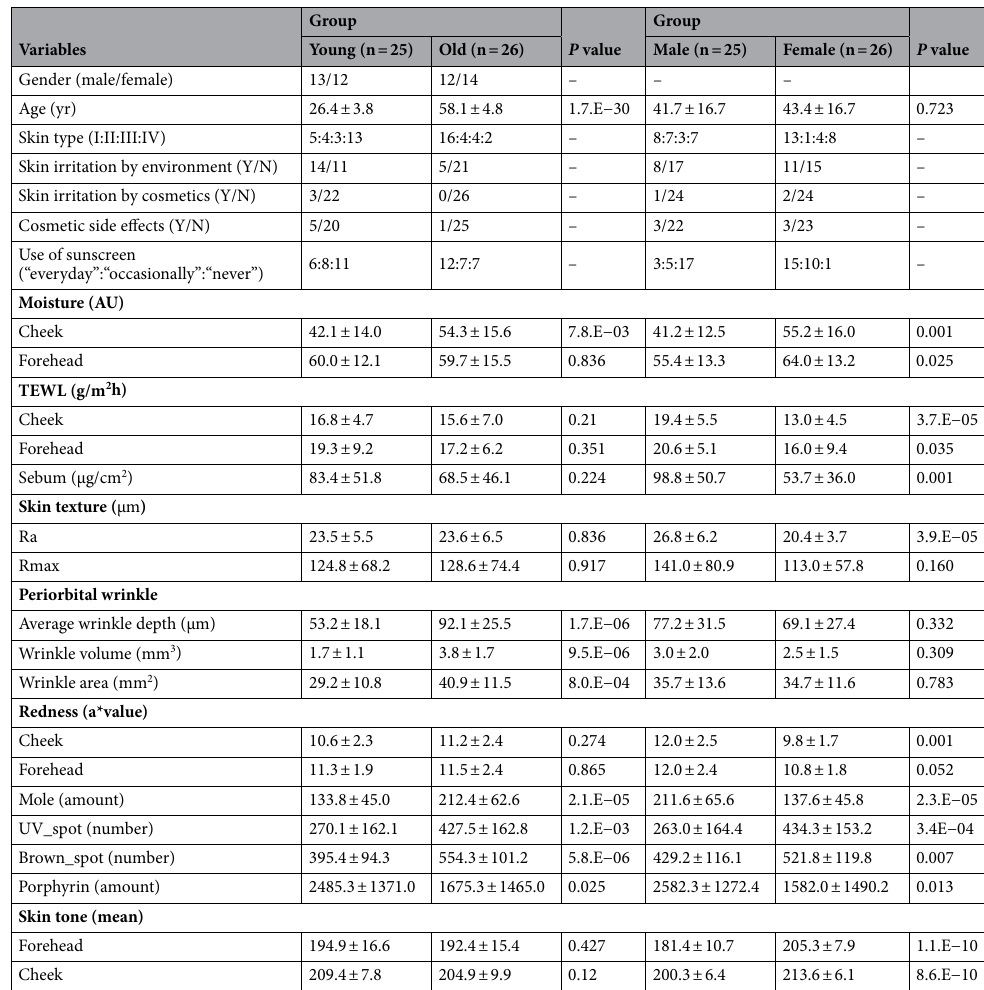
Table 1. Skin characteristics of the subjects by age and gender. Data is expressed as the mean ± standard deviation. Skin type I:II:III:IV = dry:oily:normal:combination; AU, arbitrary unit; TEWL, transepidermal water loss; Ra, arithmetic average roughness; Rmax, maximum roughness